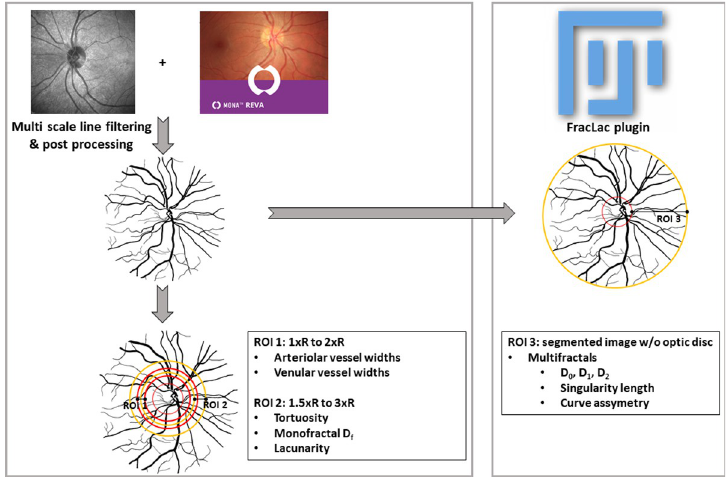
Fig 1. Calculation of retinal vessel metrics with MONA REVA software and FracLac plugin in FIJI software. The concentric circles on the segmented images indicate the regions of interest (ROIs) in which the metrics were calculated. R is defined as the radius of the optic disc (inner red circle). For ROI 1 and ROI 2, radii of the larger circles are a multiple of R. The entire segmented without the optic disc is ROI 3. Note: the segmented image is a representative example and not the segmented image of the shown greyscale